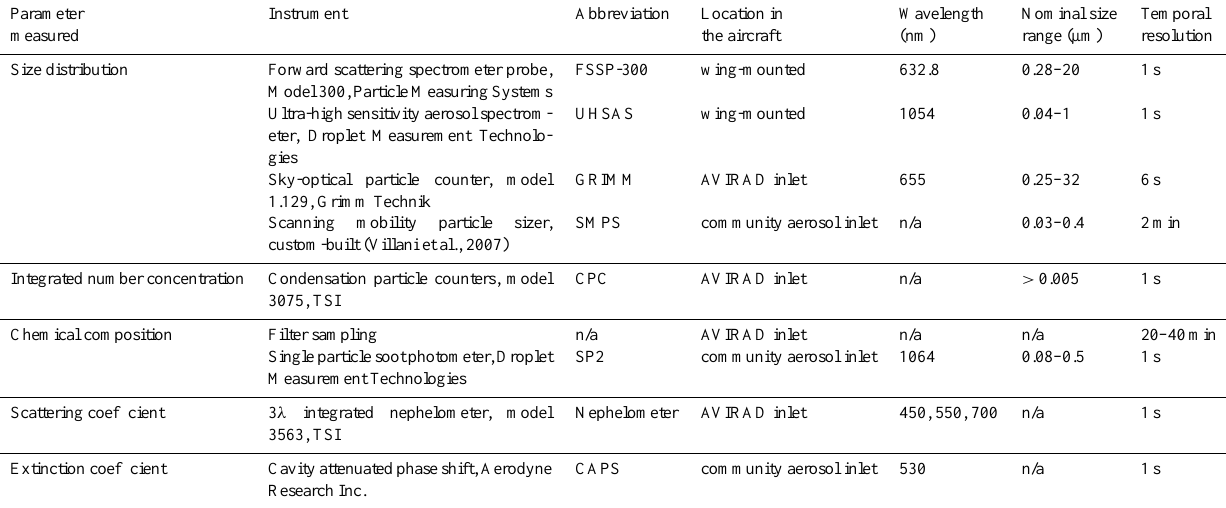
Table 2. Instruments detailed in this article operating on board the ATR-42 aircraft during the ChArMEx/ADRIMED campaign. The cut-off diameter value, expressed as optical equivalent, is 12µm for the AVIRAD inlet and 5µm for the community aerosol inlet.